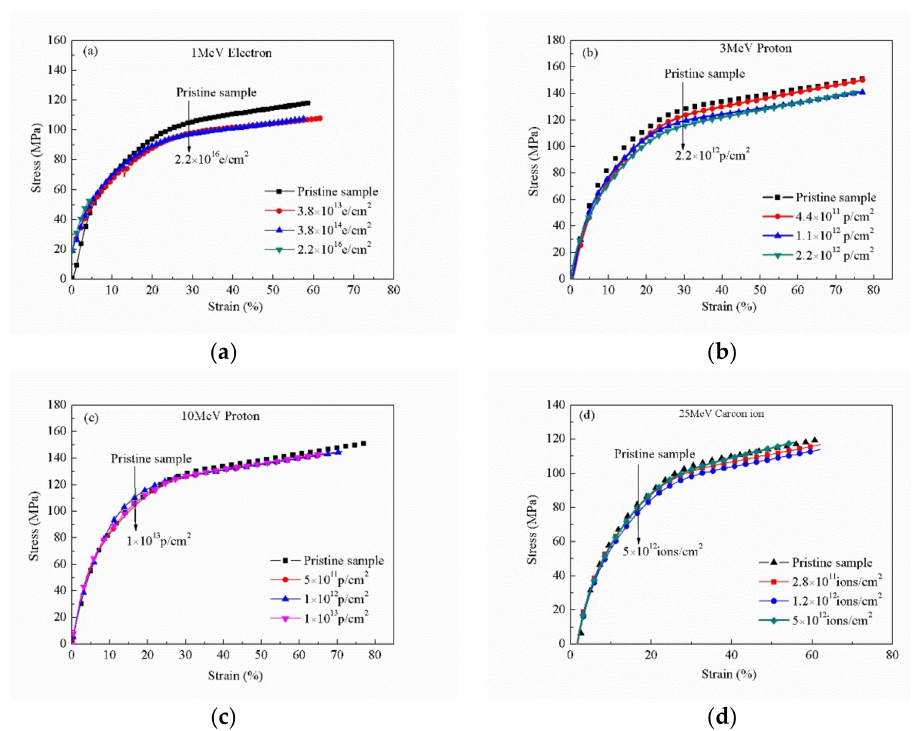
Figure 7. Stress–strain curves of pristine and irradiated PI films with di ff erent sources and fluences at room temperature: ( a ) 1 MeV electron, ( b ) 3 MeV proton, ( c ) 10 MeV proton, and ( d ) 25 MeV carbon